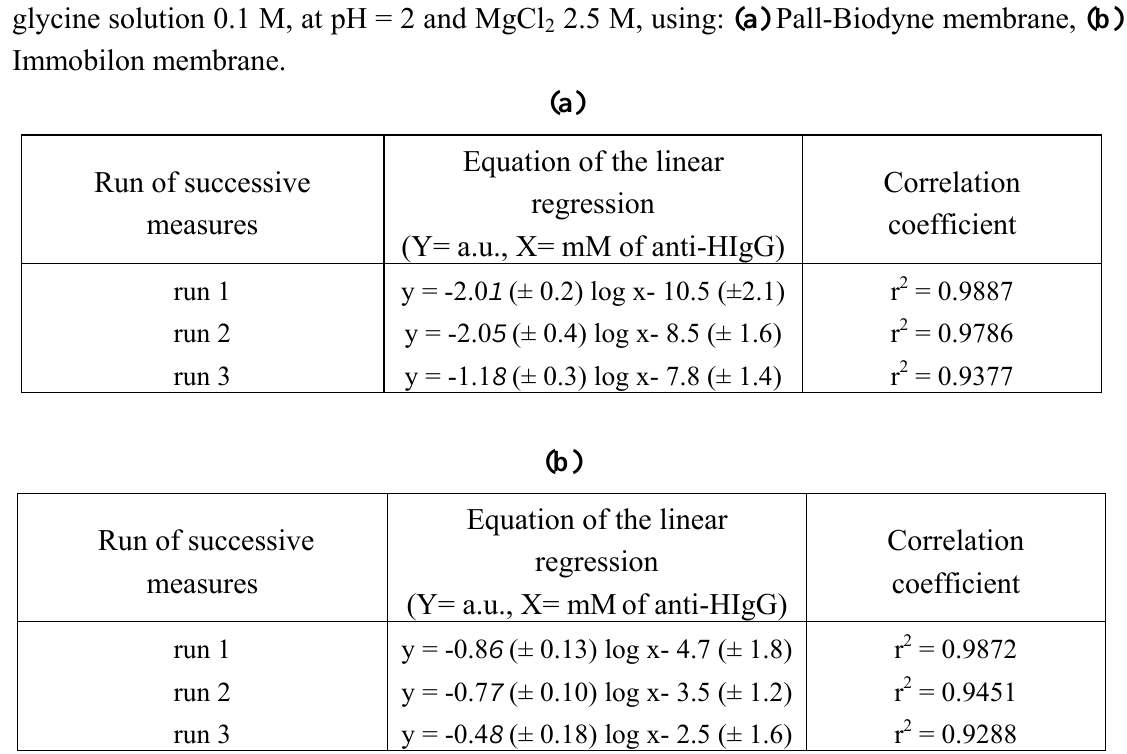
2.5 M, using: (a) Pall-Biodyne membrane, (b) 2